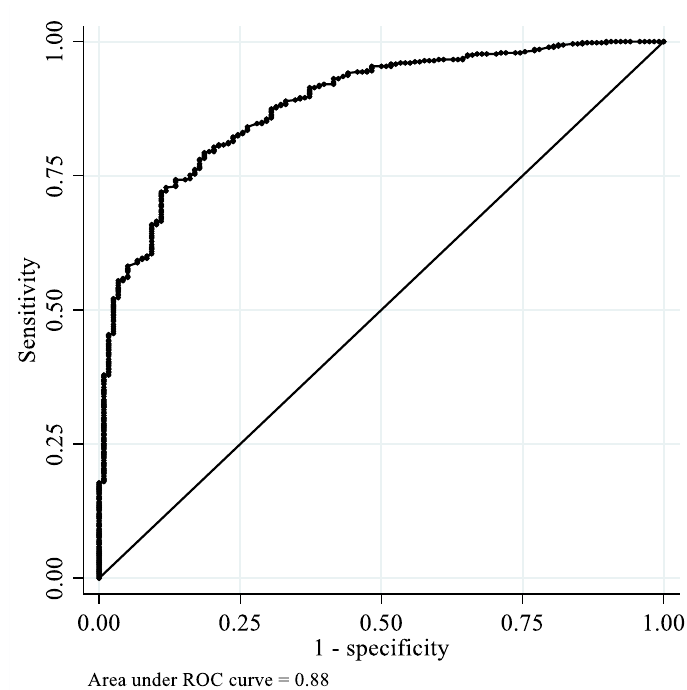
Figure 2. Receiver operating characteristic curves of OFMD-CPS-measured OF among the participants with low OF.